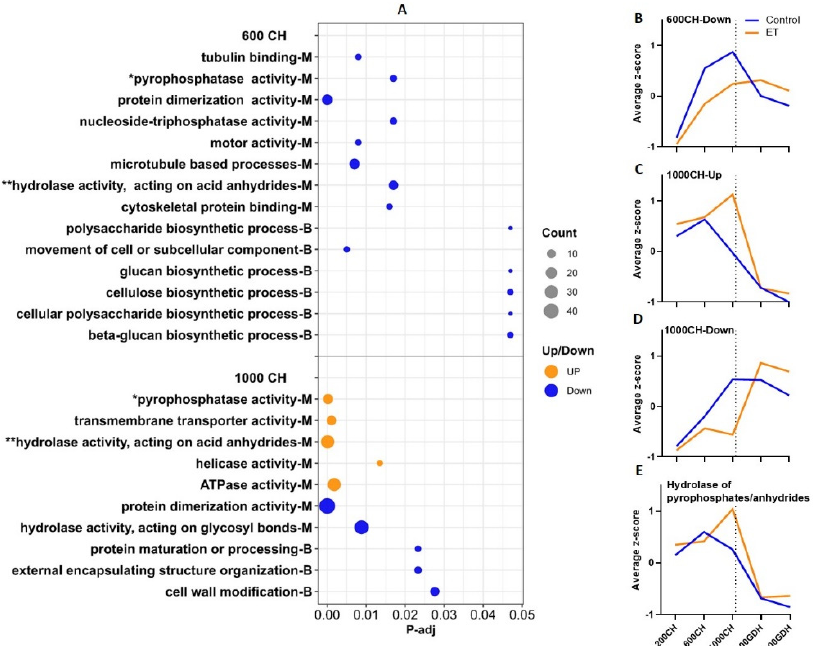
Figure 4. Enrichment analysis of DEGs between the ET treatment and the control during endodor- mancy (200, 600, and 1000 CH). ( A ) Significantly enriched GO terms (P − adj < 0.05). Letter B indicates biological processes, and M indicates molecular functions. Dot size represents the number of genes enriched in each GO term. Orange dots represent upregulated DEGs, and blue dots represent down- regulated DEGs, respectively. Asterisks (* and **) indicate GO terms that are common to both 600 CH and 1000 CH sampling time. ( B – E ) Mean z − score values of the expression (FPKM) of the DEGs from each group. The dotted lines represent the date of endodormancy release.